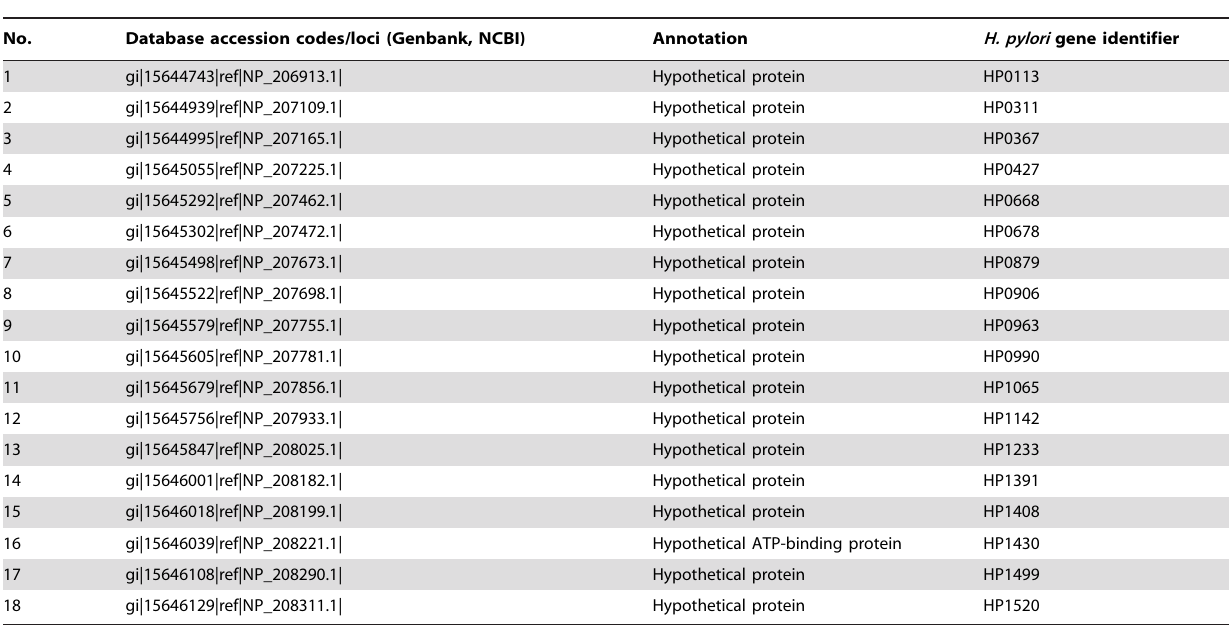
Table 3. Predicted proteins from Helicobacter pylori strain 26695 that might be exported via a Type 3 Secretion System and were predicted by both ANN and SVM